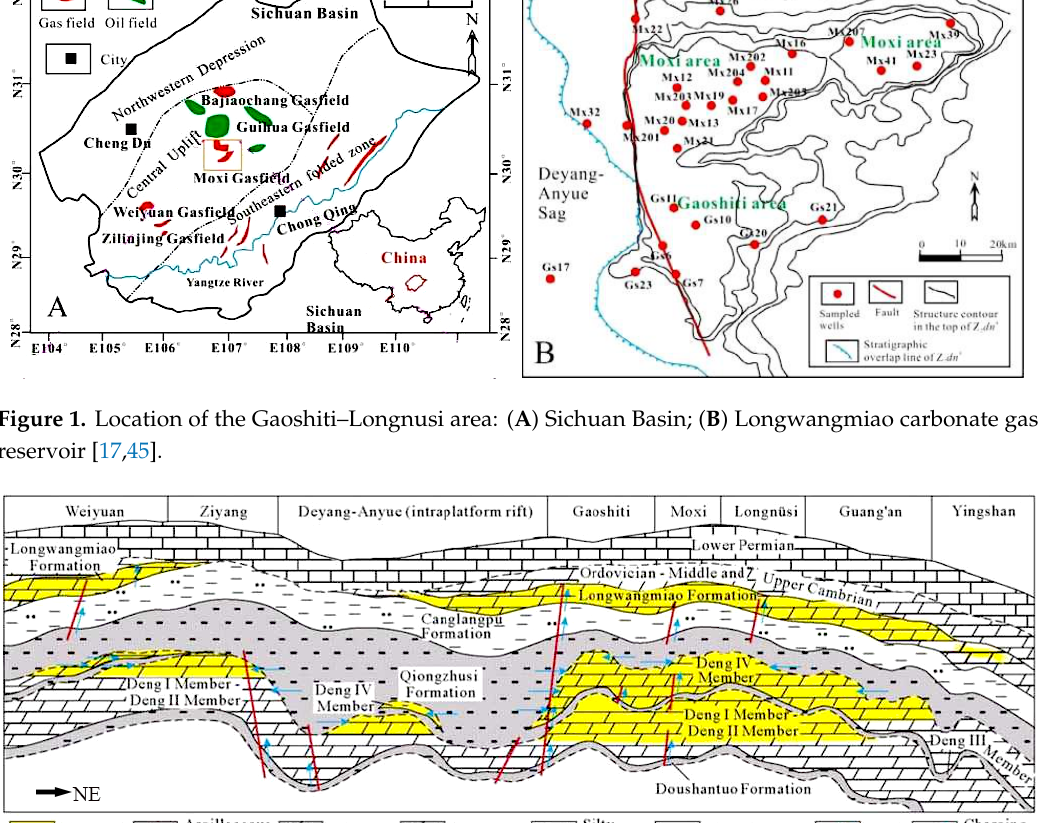
Figure 1. Location of the Gaoshiti–Longnusi area: ( A ) Sichuan Basin; ( B ) Longwangmiao carbonate gas reservoir [17,45].